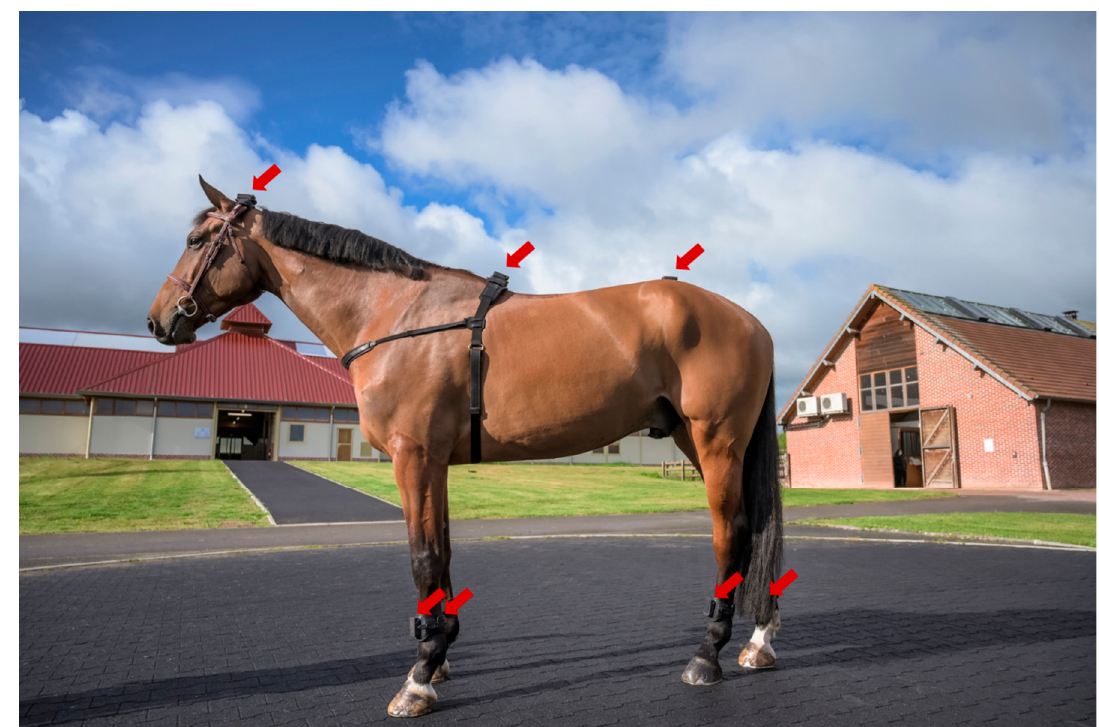
Figure 1. Horse equipped with EQUISYM® system, composed by sensors placed on the head, the withers, the pelvis and the four cannon bones (shown by the red arrows).